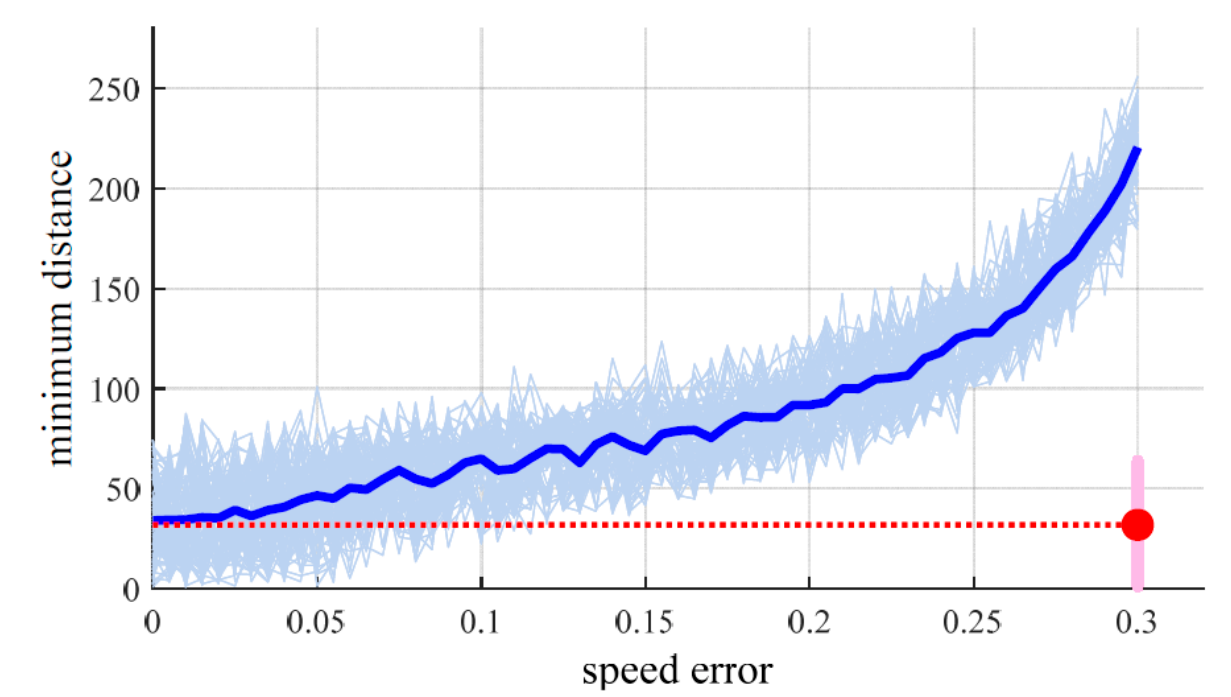
Figure 17. The minimum distance between the pursuer P 1 and evader with different ∆ v